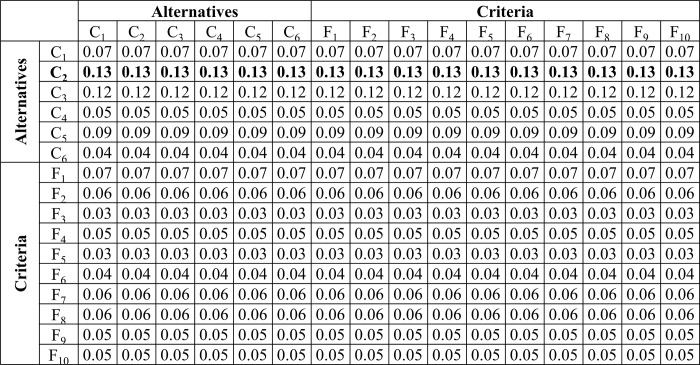
Limit super-matrix.